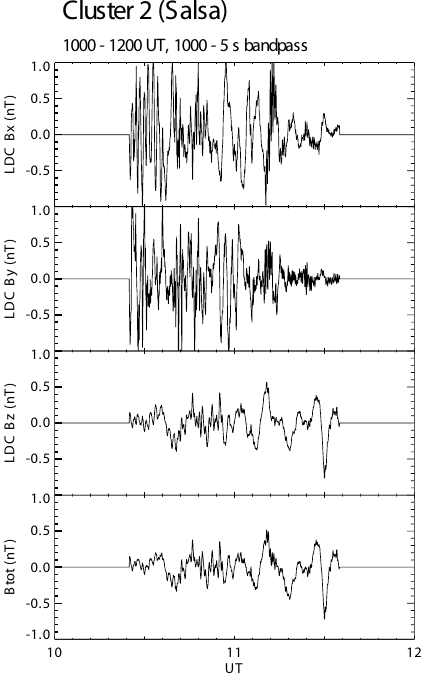
Fig. 6. Components of magnetic field data in LDC X , Y , Z com- ponent and total magnetic field as observed from spacecraft 2 of cluster for 10:00–12:00 UT after subtracting Tsyganenko-96 and bandpass filtering between 1000–5s.